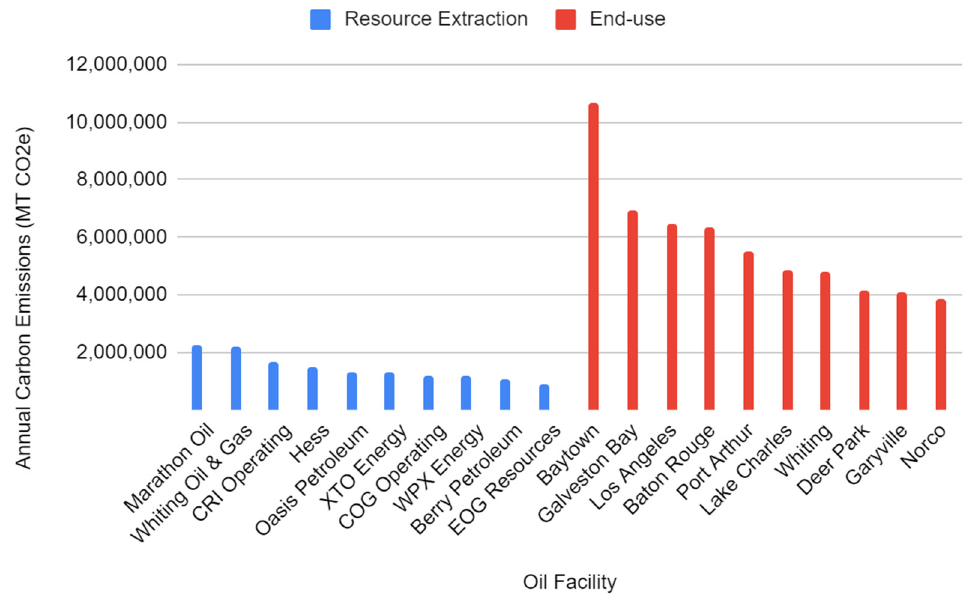
Figure 5. Top CO 2 Emission Point-Sources of the Oil Industry for Resource Extraction and End-use.